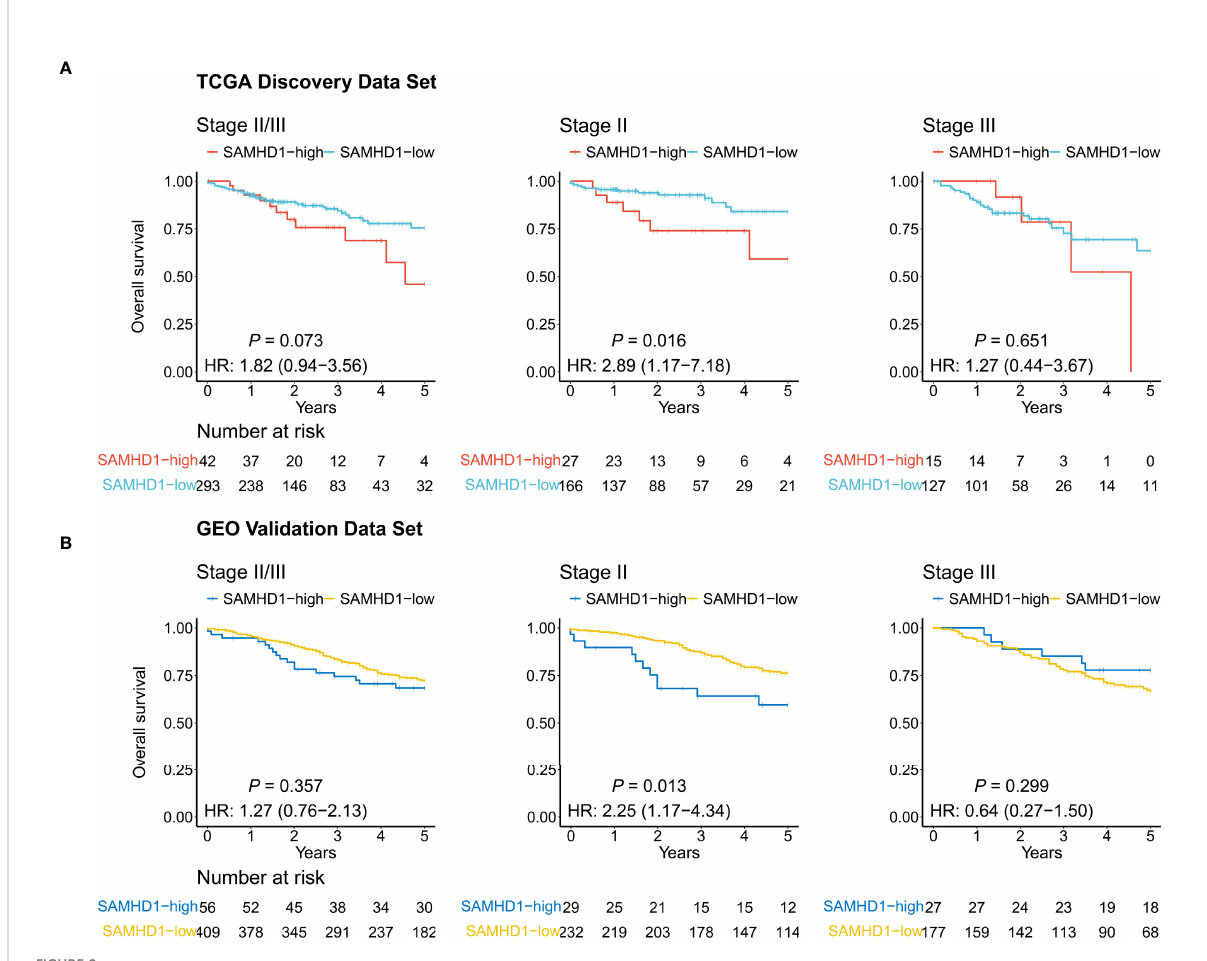
FIGURE 2 Kaplan – Meier curves. The curves show the relevance between the 5-year overall survival and SAMHD1 gene expression status in colorectal cancer, using The Cancer Genome Atlas data (TCGA) (A) and Gene Expression Omnibus data (GEO) (B) . Left: Patients with stage II and III disease. Middle: Patients with stage II disease. Right: Patients with stage III